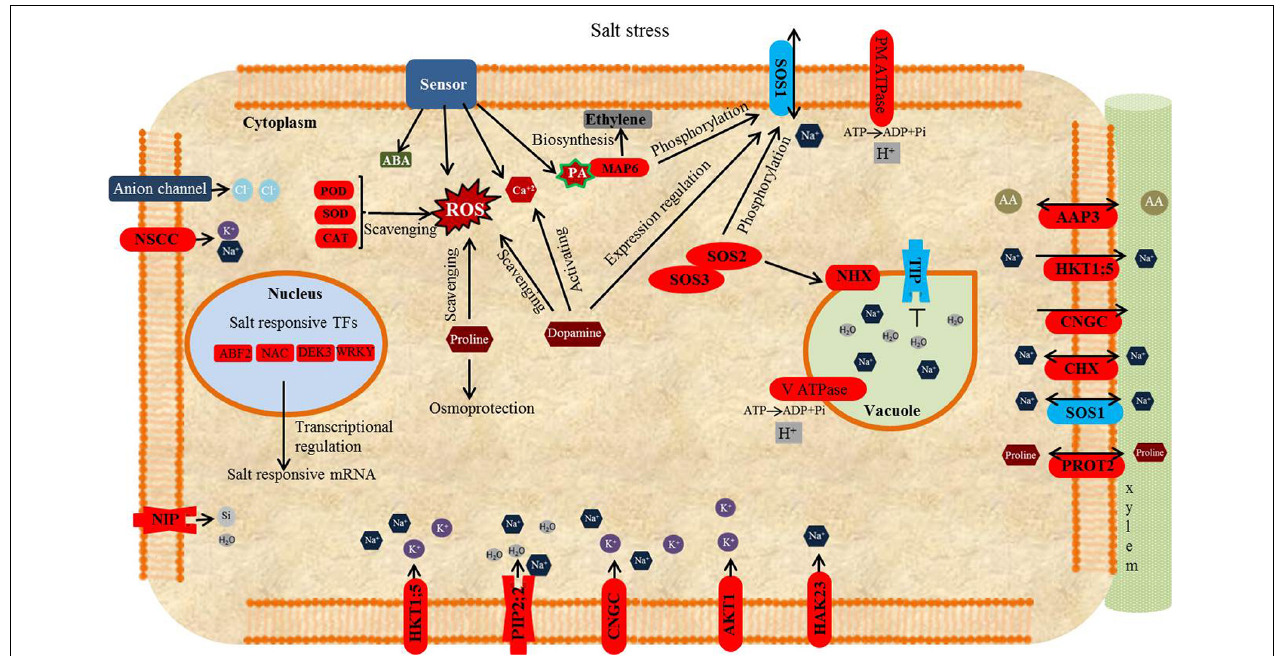
FIGURE 12 | A model proposed for the responses of Puccinellia nuttalliana to NaCl based on root transcriptomic and metabolomic analyses. NaCl is sensed by the salt sensors which triggers cytosolic Ca 2 + accumulation in the cytosol. Ca 2 + activates SOS3 leading to the formation of SOS3-SOS2 complex. This complex triggers the activation of downstream SOS1. Salt stress induces the activation of NaCl-responsive TFs, important regulators of salt responsive genes. TIPs are down-regulated to slow down water efflux from vacuoles. PIP2;2 is up-regulated to lower resistance of plasma membrane to water influx into the cytoplasm and transport of Na + ions. Several antiporters, NHX, HKT, SOS1, PIP2;2, AKT, HAK, CNGG, and NSCC are differentially expressed to facilitate intra- and intercellular K + and Na + homeostasis in Puccinellia nuttalliana under salt stress. Na + transport across the plasma membrane driven by the H + gradient occurred by plant proton pumps, H + -ATPase and V-ATPase. Na + is sensed by sensors leading to the enhanced accumulation of ROS. The function of proline accumulation under salt stress is to provide osmotic adjustment and scavenging of ROS. Dopamine improves the antioxidant capacity by scavenging ROS, regulate the expression of SOS1 and activating Ca 2 + signaling pathway. Phosphatidychlines increased for membrane lipid remodeling to regulate fluid and ion permeability and maintain membrane integrity under saline environment. Salt stress elevates the level of PA, a direct activator of MPK6. MPK6 e is involved in regulating ethylene biosynthesis